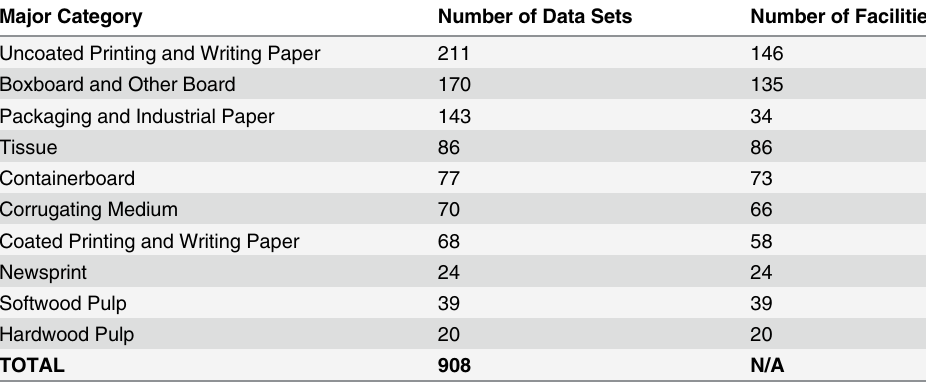
Table 4. Summary of production by major product